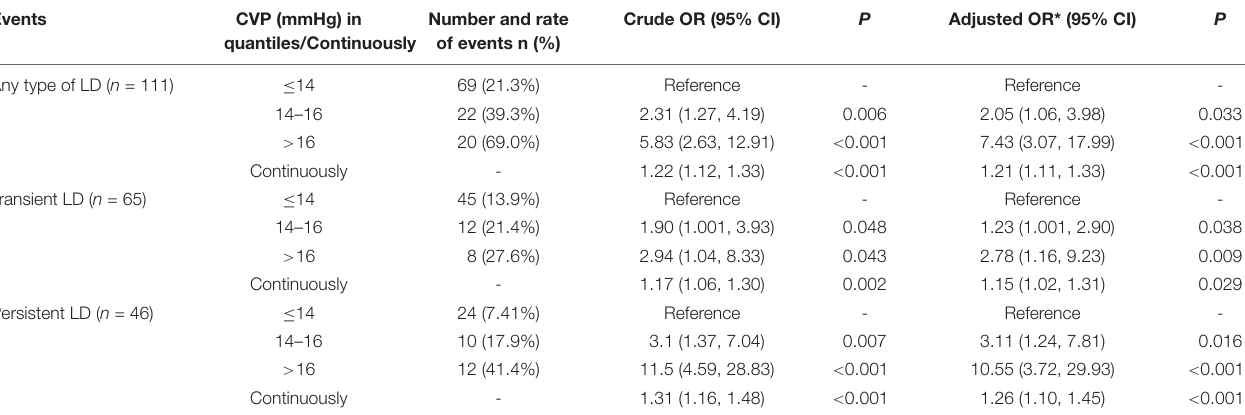
TABLE 3 | Univariate and multivariate logistic analysis of the association between postoperative CVP and postoperative any type of LD, transient LD and persistent LD.